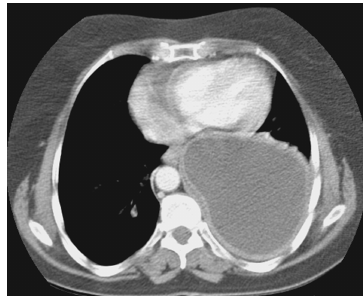
Figure 6. Contrast-enhanced computed tomography scan of thorax showing giant hydatid cyst of left lung.